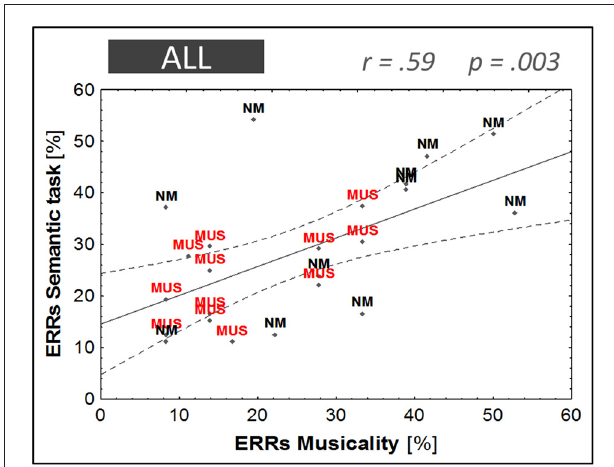
FIGURE 7 | Linear regression model . Musical aptitude (ERRs in the musicality task) against word learning performance (ERRs in the semantic task). Children with music training are illustrated in red (MUS) and children without music training in black (NM).